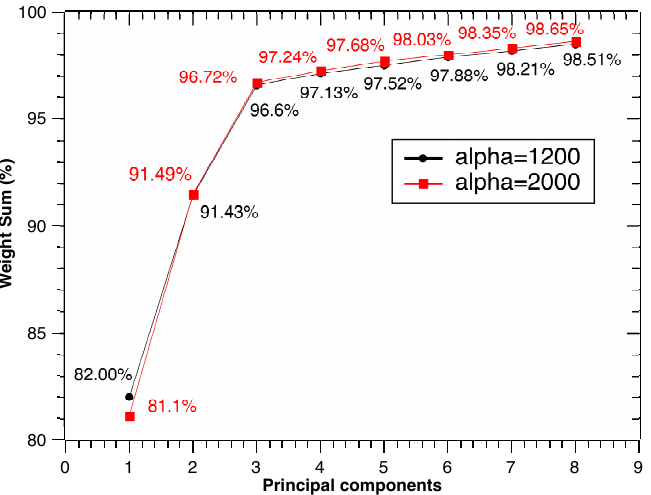
Figure 8. Robustness of the PCA space under parameter interval α = [ α , α ]